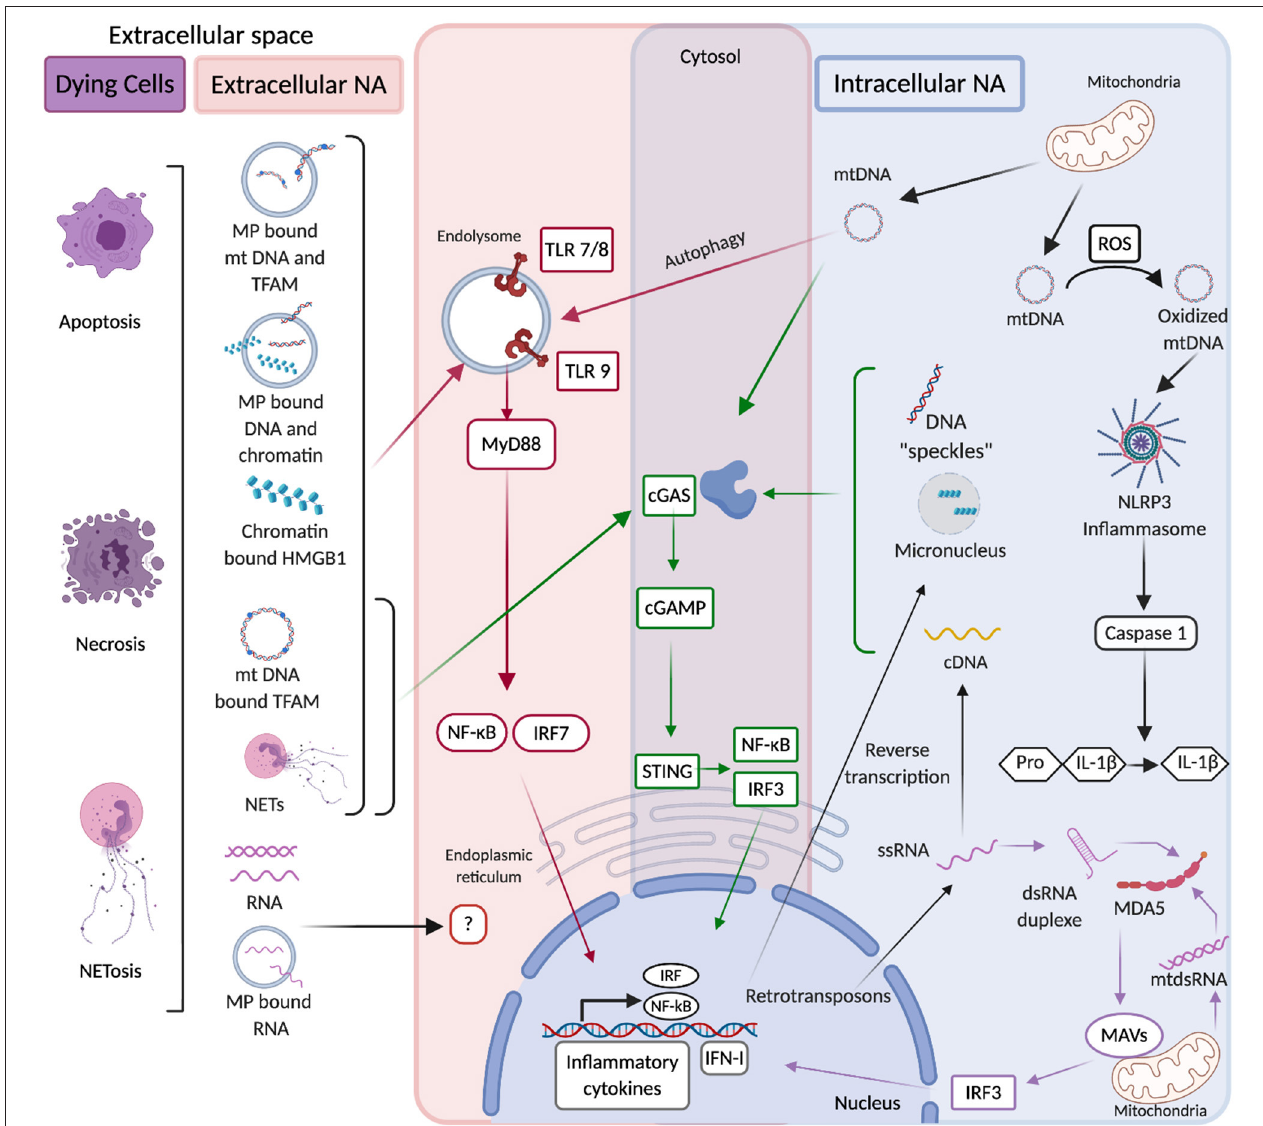
FIGURE 1 | In red are extracellular source of NAs that originate from dying cells in multiple forms including free, microparticle (MP)-associated, Neutrophil Extracellular Trap (NET)-associated, and protein-associated (Histones, HMGB1, and TFAM). Such NAs can be internalized into endolysosomes where they are recognized by Toll like receptors (TLR), which via MyD88 activate NF-kB and IRF7 transcription factors that upon their translocation to the nucleus induce the production of inflammatory cytokines and type I interferons (IFN-I). The detection of extracellular RNA by NA-sensing PRRs is poorly documented. In blue are represented intracellular sources of NAs. They originate from mitochondria and such mtDNA in the presence of ROS (reactive oxygen species) can be oxidized and acquire the ability to activate NLRP3 inflammasome, which triggers caspase 1-mediated cleavage of pro-IL-1 β into active IL-1 β . mtDNA can also activate cGAS which upon detection of DNA produces cGAMP that is specifically recognized by STING. STING stimulation triggers IRF3-mediated IFN-I production and NF-kB-mediated inflammatory cytokine production. Upon autophagy mtDNA can gain access to endolysosomal compartments and stimulate TLR9 as well. Furthermore mitochondrial double-stranded RNA (mtdsRNA) if not degraded by mitochondrial RNA-degradosome machinery can activate the RNA sensor MDA5 which via the adaptor molecule MAVS activates IRF3-mediated IFN-I production. Endogenous LTR-retrotransposons are also a source of intracellular NAs, they can lead to the production of dsRNA duplexes that activate IFN-I production after their sensing by MDA5. In purple are common pathways of intracellular and extracellular NA sensing. mtDNA and NET-associated DNA from the extracellular space are internalized in the cytosol and activate cGAS. The same pathway can be activated by ssDNA originating from the reverse transcription of endogenous LTR-retrotransposons and by nuclear DNA released into the cytosol during stress conditions in forms of micronuclei or “speckles”.